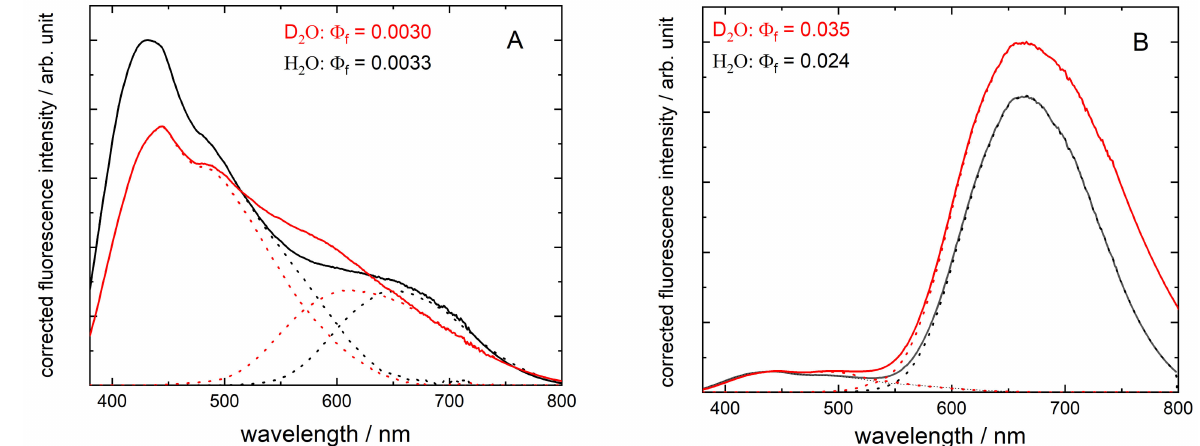
Figure 1. Corrected fluorescence spectra of BSA–Au conjugates in normal (black lines) and heavy water (red lines). In ( A ), the arbitrary intensities are multiplied by a factor of ten, compared with ( B ), the luminescence was detected just 2 h after reaching pH (pD) = 12, whereas in ( B ), after conditioning the samples at pH (pD) = 12 for 2 d, and subsequently neutralizing to pH = 7 (pD ≈ 7) (2 d). (The dotted lines indicate an approximate resolution of the reddest band and the other two bands together.).